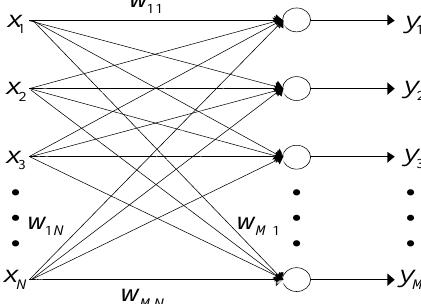
Figure 1. A neural network model of LEAP, an online unsupervised learning machine.